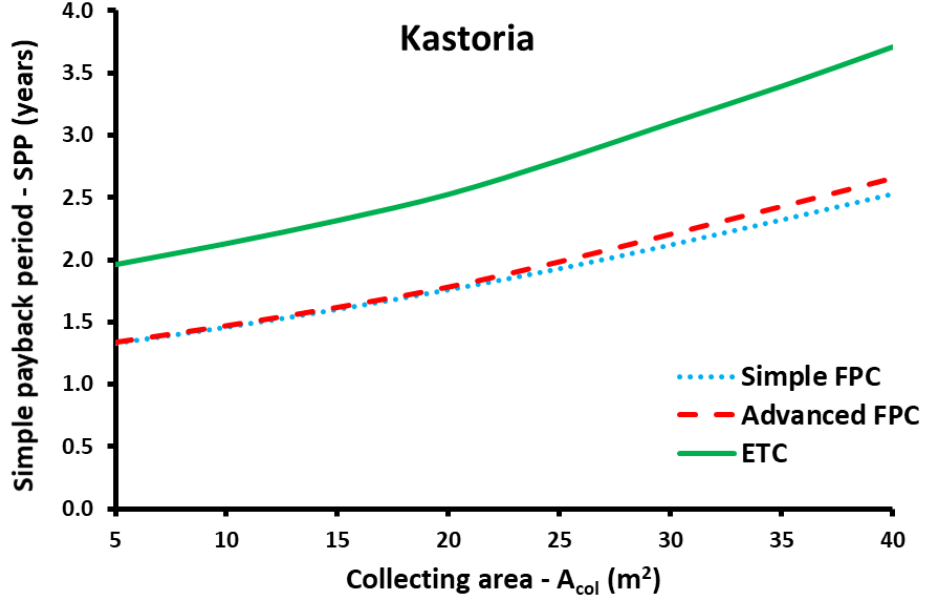
Figure 27. Simple payback period for different collecting areas and collector types for Kastoria.